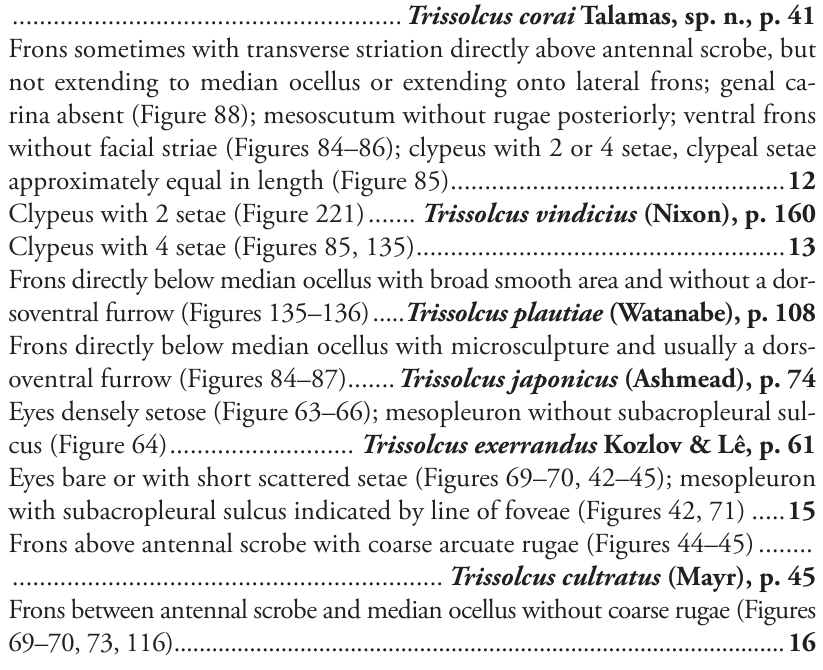
4 setae, lateral clypeal setae about half as long as medial setae (Figure 39)